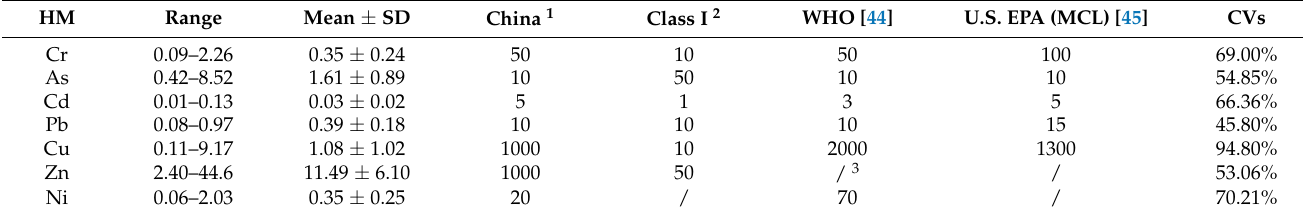
Table 3. Statistics of heavy metal concentrations ( n = 110).